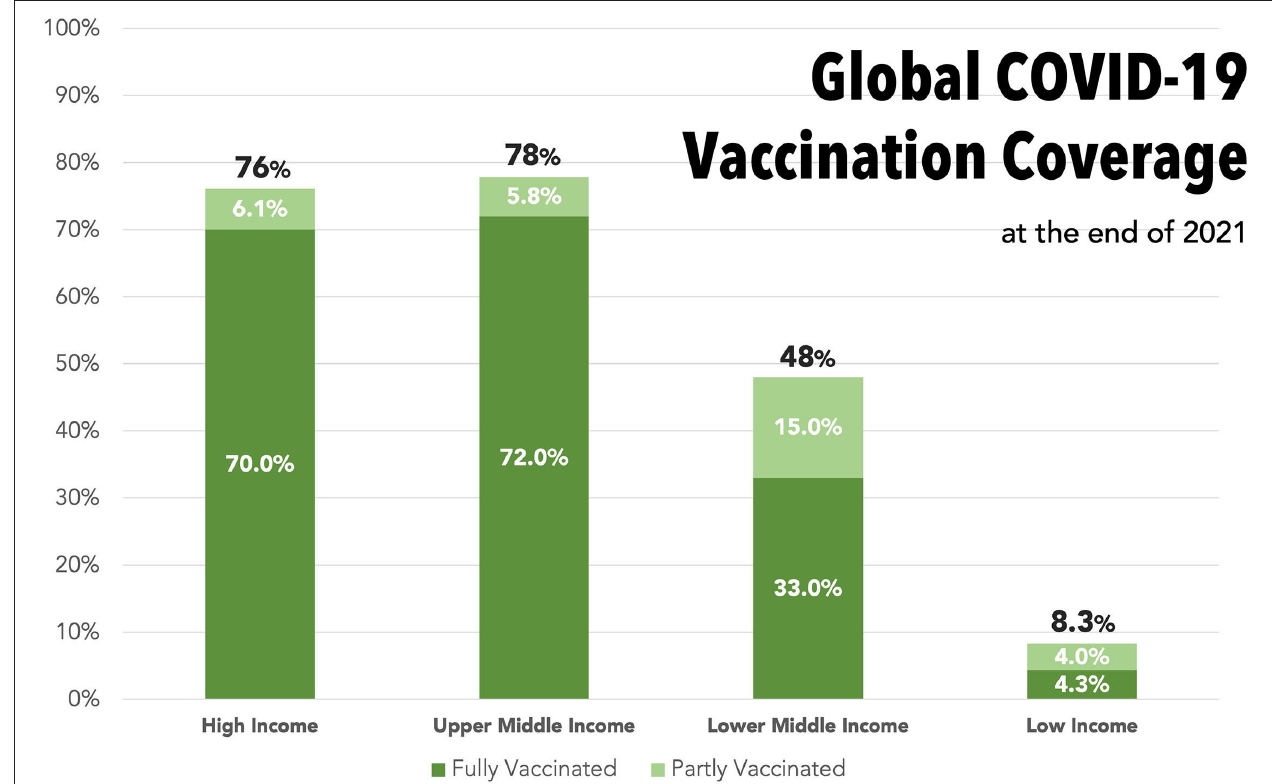
FIGURE 1 | Bar graph displaying the proportions of the overall population who had received part (1st vaccine) or completed (2nd vaccine) a COVID-19 vaccination course by the end of 2021, stratified into World Trade Organization income categories. Dark green, completed course; Light green, partially vaccinated. Total proportion who have received any vaccine is stated at top of each bar. Data from Our World in Data—timepoint 31/12/21 (